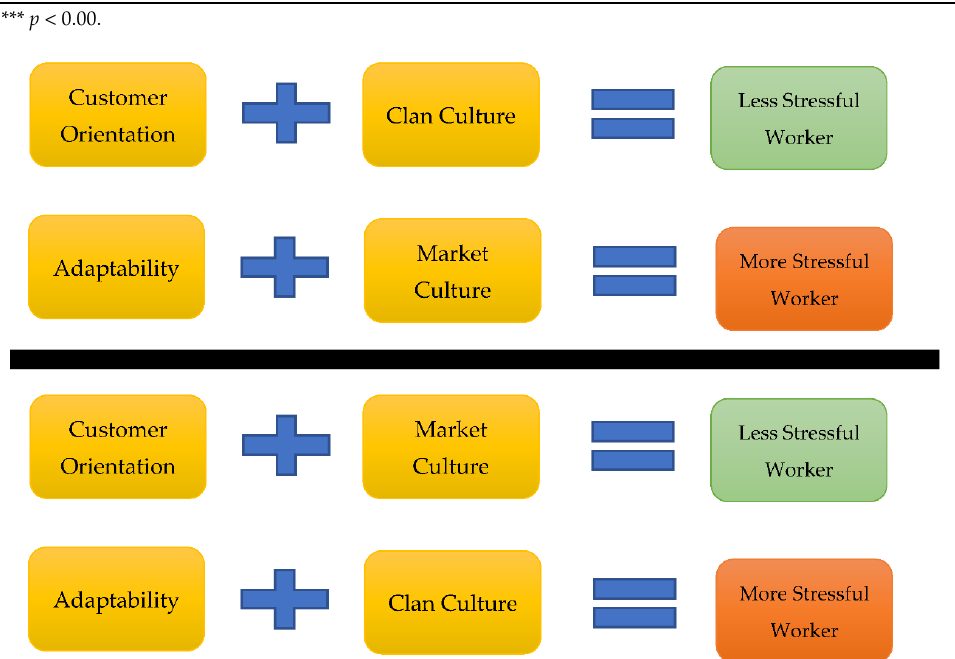
Figure 1. Research Subject of the Present Study. Identifying these negative associations among our main constructs, we could recognize that there exists a strong discriminant validity [1,66,69]. After the convergent validity was measured, the discriminant validity was tried utilizing the Fornell and Lacker [70] law. Theoretically, the discriminant validity investigated the intercorrelation between main factors and noticeable covering figures. As shown in Table 9, the study, based on the Fornell and Lacker’s approach, every value of square roots of AVEs is more significant in every circumstance than the off-slanting components in their comparison line and section. Thus, they indicate that the critical discriminant acceptability has been refined. Table 9. The Results of Discriminant Validity. Construct